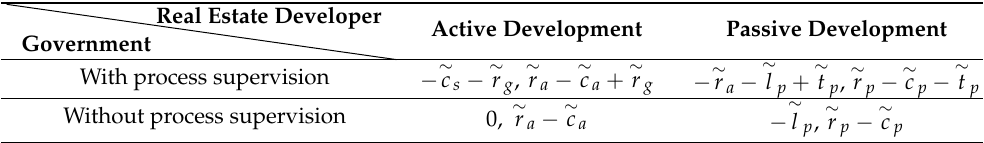
Table 1. Triangular fuzzy profit and loss value matrix of game between government and real estate